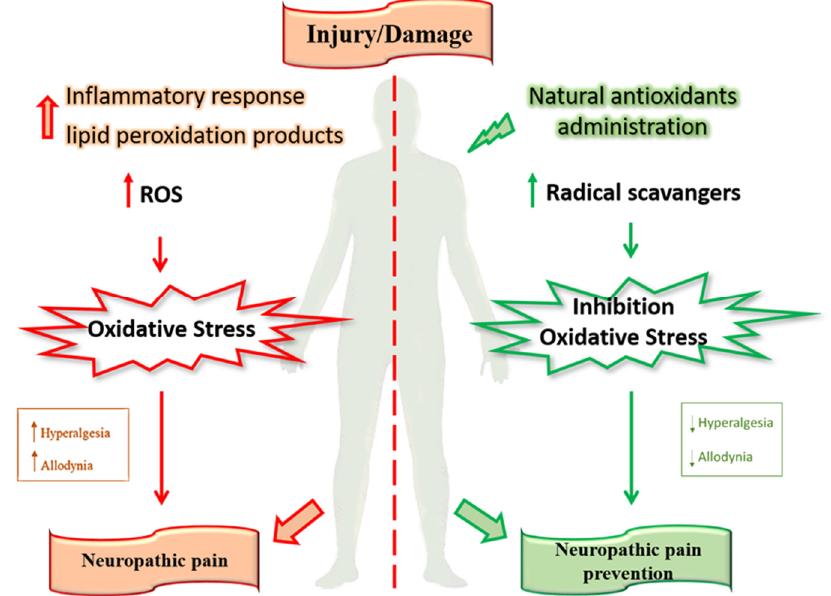
Figure 2. Role of natural antioxidants in pain prevention.